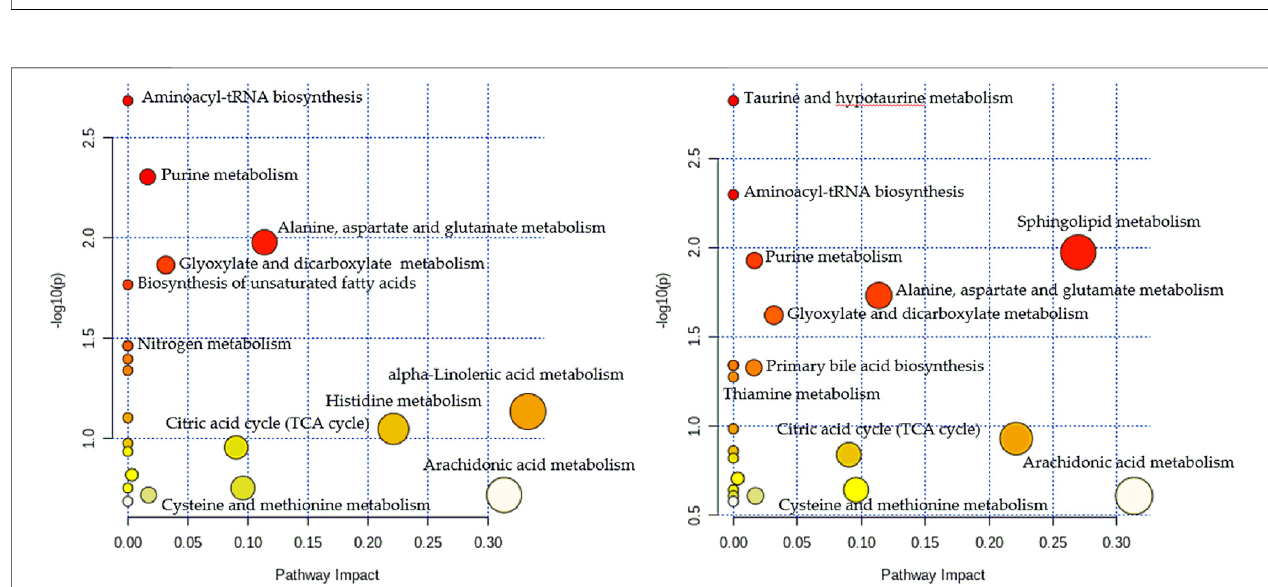
FIGURE4 | Metabolomics pathway analysisindicatingselect metabolic pathways that are signi fi cantlyaffectedin the Shi (A) and Xu (B) subtypes ofCHI). p values are shown on the Y -axis, and pathway impact values are shown on the X -axis. The nodes are coloured based on p -value, while node sizes indicate impact values.